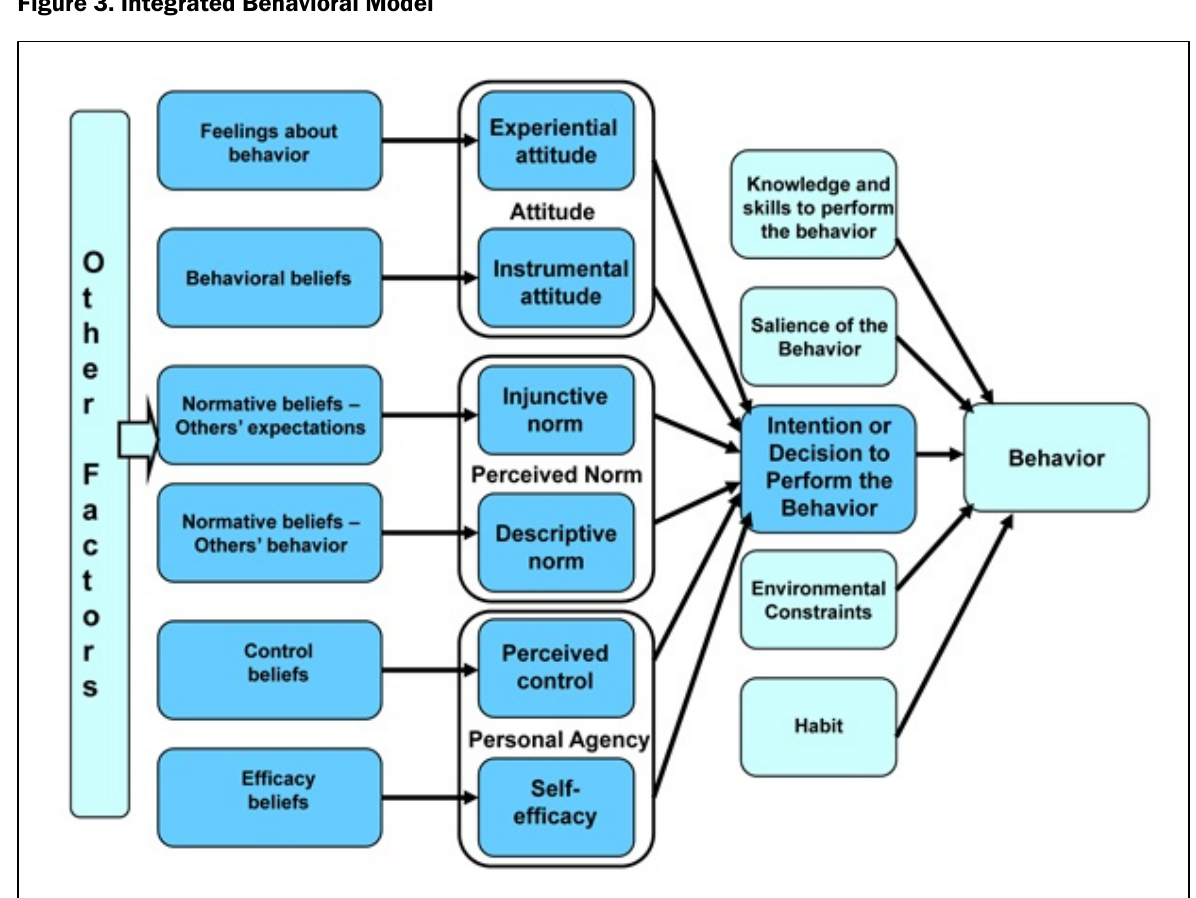
Figure 3. Integrated Behavioral